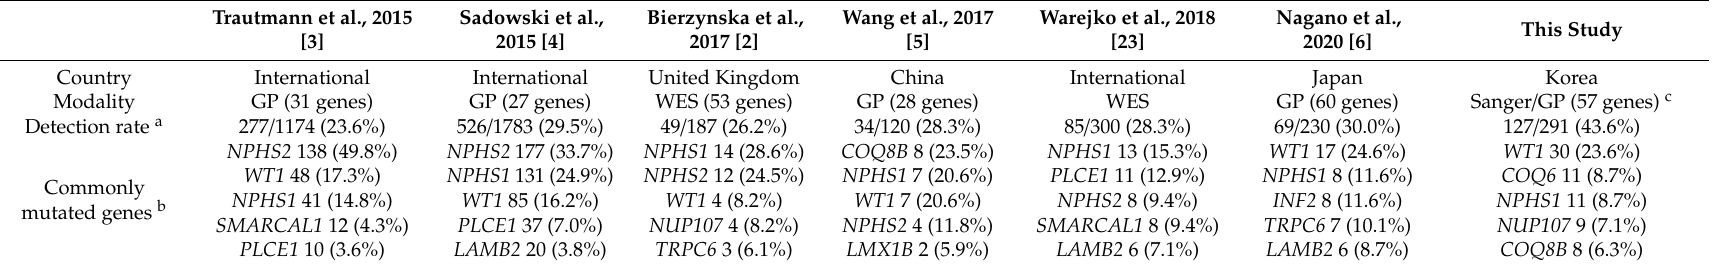
Table 3. Genetic studies in large cohorts of pediatric patients with steroid-resistant nephrotic